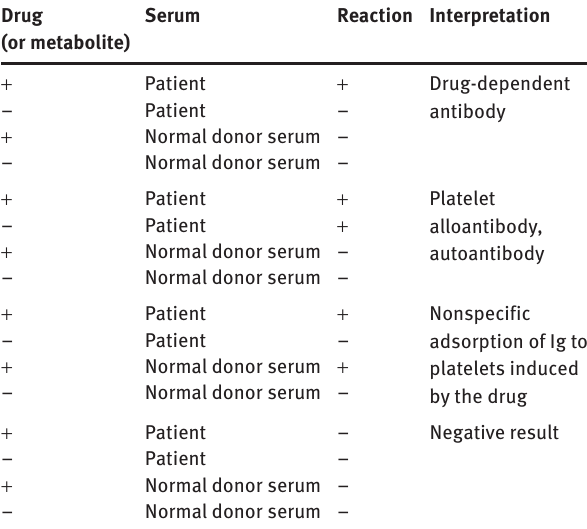
Table 1: Interpretation of immunoglobulin binding assays for the detection of drug-dependent